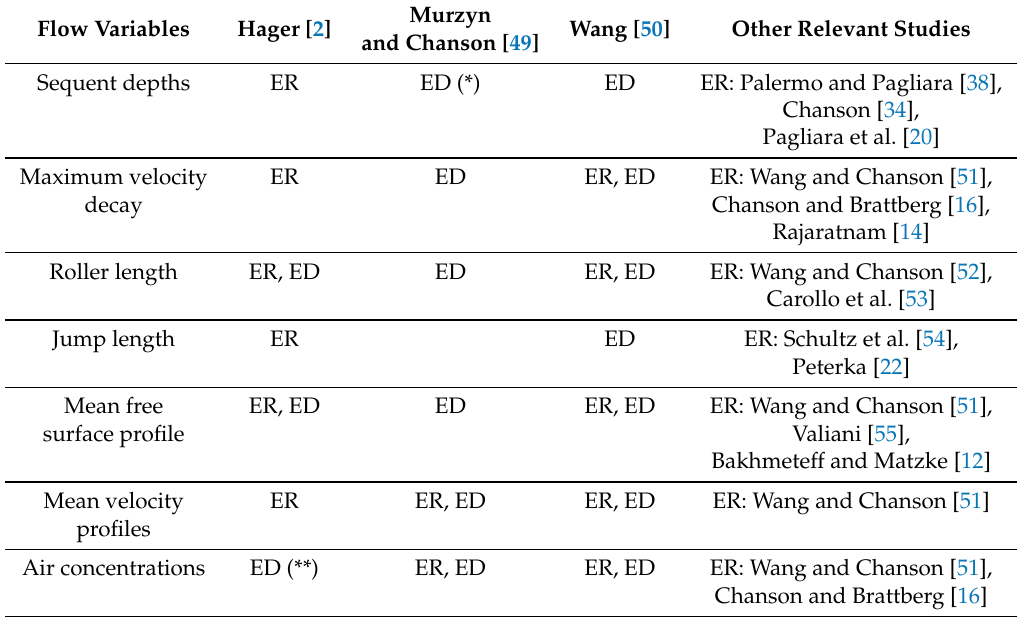
Table 2. Available experimental results for mean variables validation of computational fluid dynamics (CFD) models. Empirical or semi-theoretical relations (ER) and experimental data